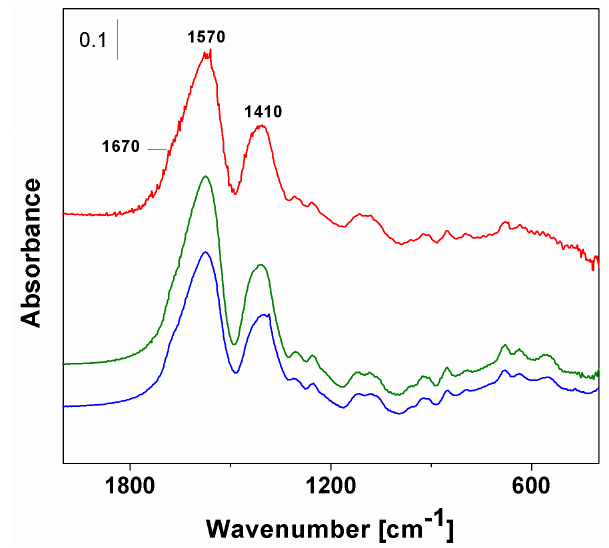
Figure 2. Fourier-transform infrared (FT-IR) spectra of Gd 2 O 3 (red), Gd 2 O 3 :Yb (LL) (green) and Gd 2 O 3 :Yb (HL) (blue).